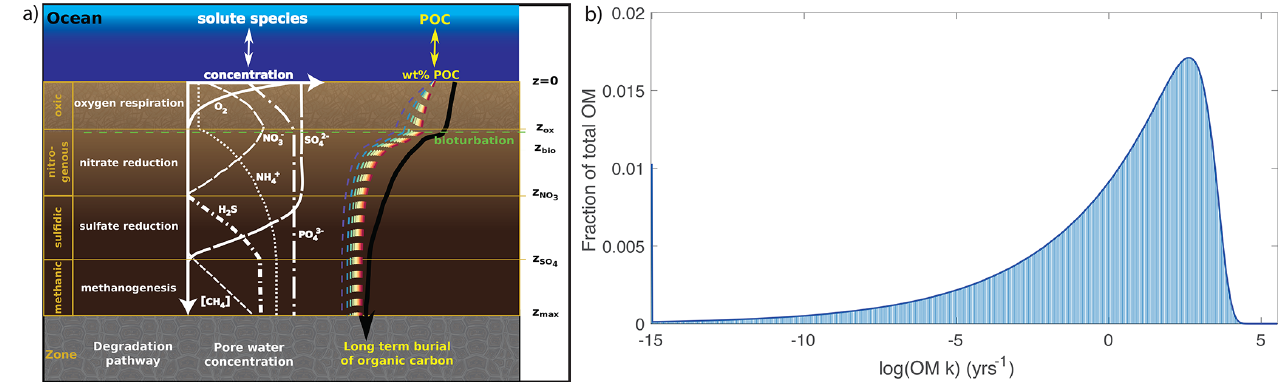
Figure 1. (a) Illustration of the different modelled species and redox zones resolved in OMEN-SED, here showing the case of z ox < z bio < z < z . The black line represents the depth profile of bulk OM concentration, which is the sum of all OM fractions, i (coloured lines) NO − 3 SO 2 − 4 (adapted from Hülse et al., 2018); (b) approximation of the reactive continuum model (continuous dark blue line) with a 500-G model (light blue